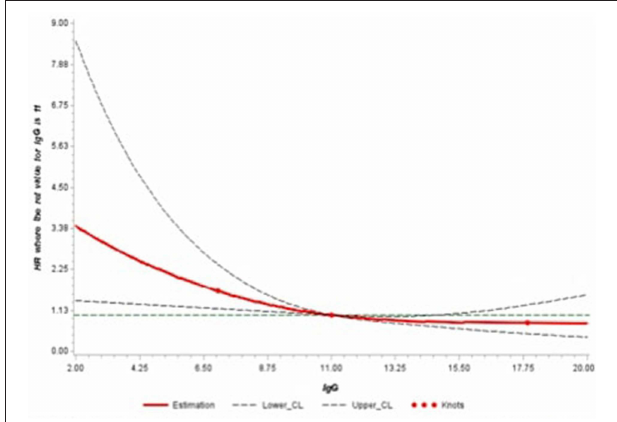
FIGURE 1 | Adjusted dose-response association between serum levels of IgG and risk of melanoma using restrictive cubic